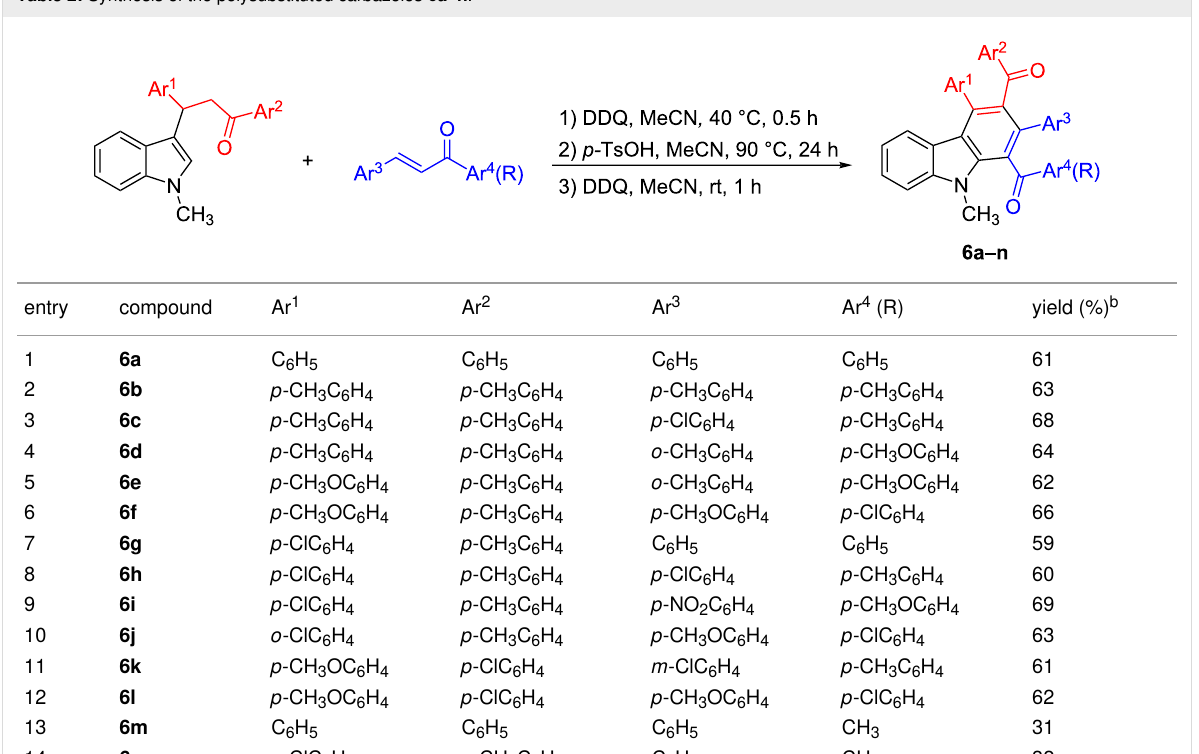
Table 2: Synthesis of the polysubstituted carbazoles 6a – n . a